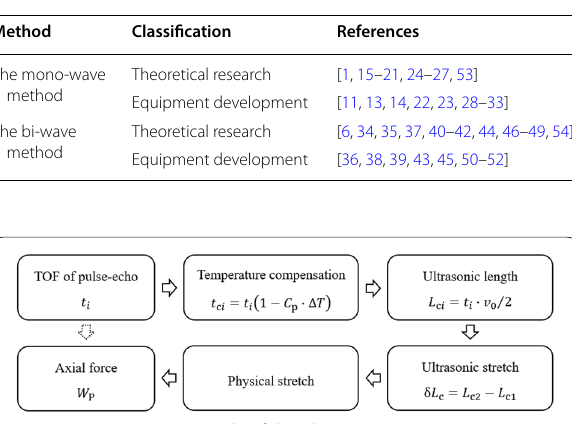
Figure 9 Operating principle of the ultrasonic